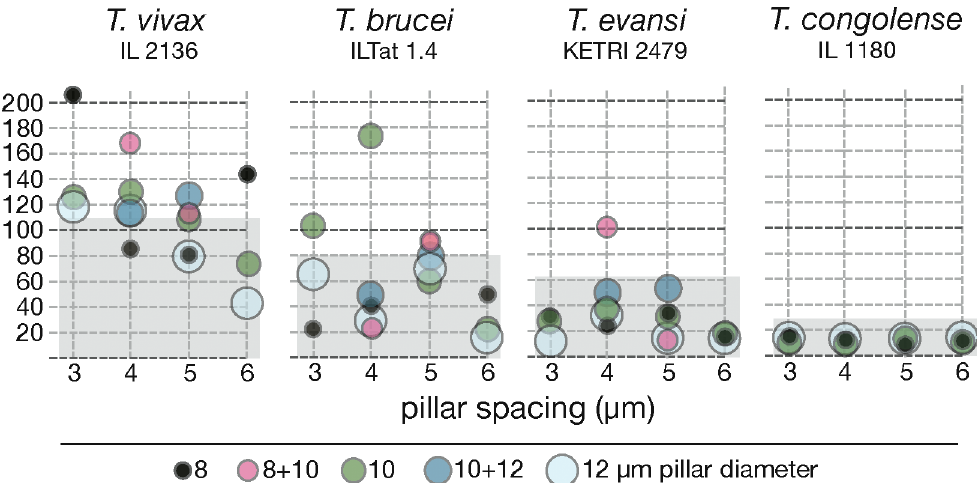
Fig 8. Motile trypanosomes are accelerated by arrays of obstacles mimicking the cellular environment of the bloodstream. The parasites were harvested from infected mice and incubated in PDMS pillar arrays of varying geometries (n (cid:1) 200/ species). Swimming velocities of persistently swimming cells were measured as before (see Fig 6) and the maximum speeds determined. The grey shades indicate the range of swimming speeds measured in other experiments, i.e. in high viscosity media or wet blood films. The comparison allows the visualisation of maximal swimming speed increase as a function of defined pillar parameters. T . brucei and T . evansi swim most efficiently in pillars of 8 – 10 μ m diameter with 4 μ m spacing, while T . vivax reveals very high maximum speeds in even narrower pillar arrays. T . congolense was also included in the experiment, however, did not reveal any persistent motion in the pillar